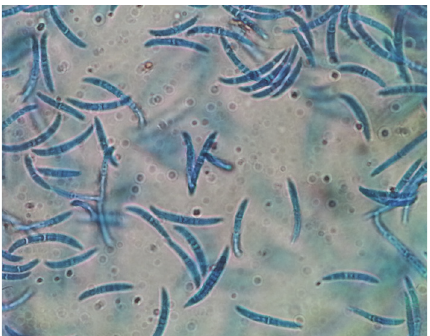
Figure 3: Macroscopic view of M. canis (forward view).